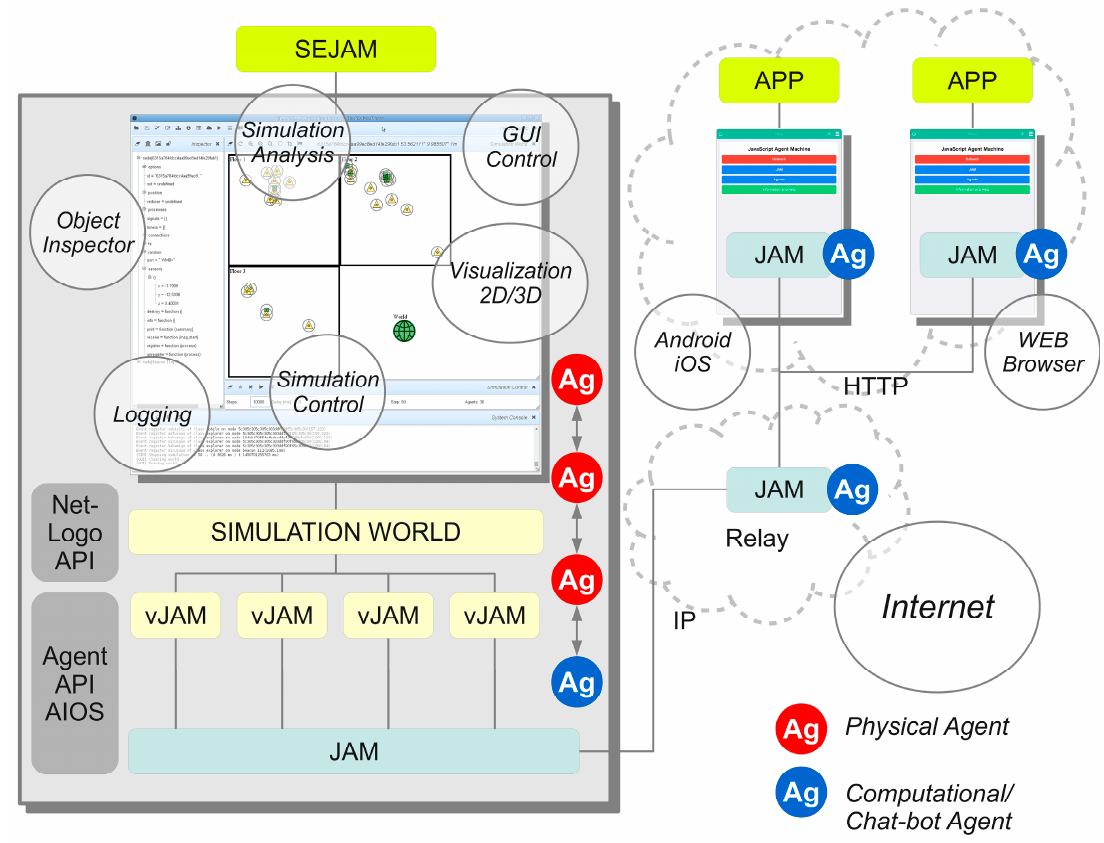
Figure 2. The principle concept of closed-loop simulation for augmented virtuality: ( Left ) Simulation framework based on the JavaScript agent machine (JAM) platform ( Right ) Mobile and non-mobile devices executing the JAM platform connected with the virtual simulation world (via the Internet) [24].